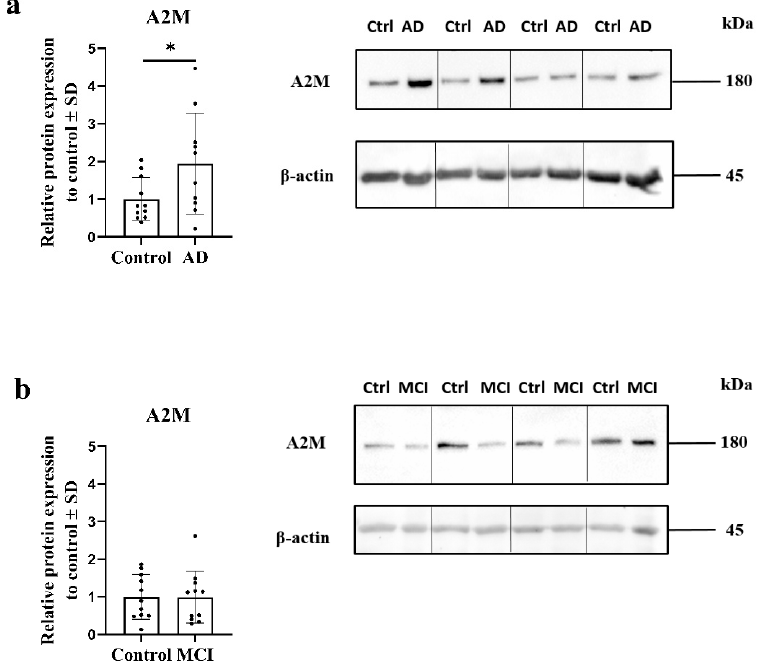
Figure 2. Western blot of A2M and β -actin in ( a ) AD olfactory mucosa (OM) cells and ( b ) MCI OM cells and the analysis of band intensities normalized to β -actin. All data are presented as mean ± SD. ( a , b ) n = 11 control lines, ( a ) n = 10 Alzheimer’s disease (AD) lines, ( b ) n = 11 mild cognitive impairment (MCI) lines. Outliers within the data groups were tested with iterative Grubb’s method (alpha 0.05). Unpaired two-tailed t -test. * p ≤ 0.05.